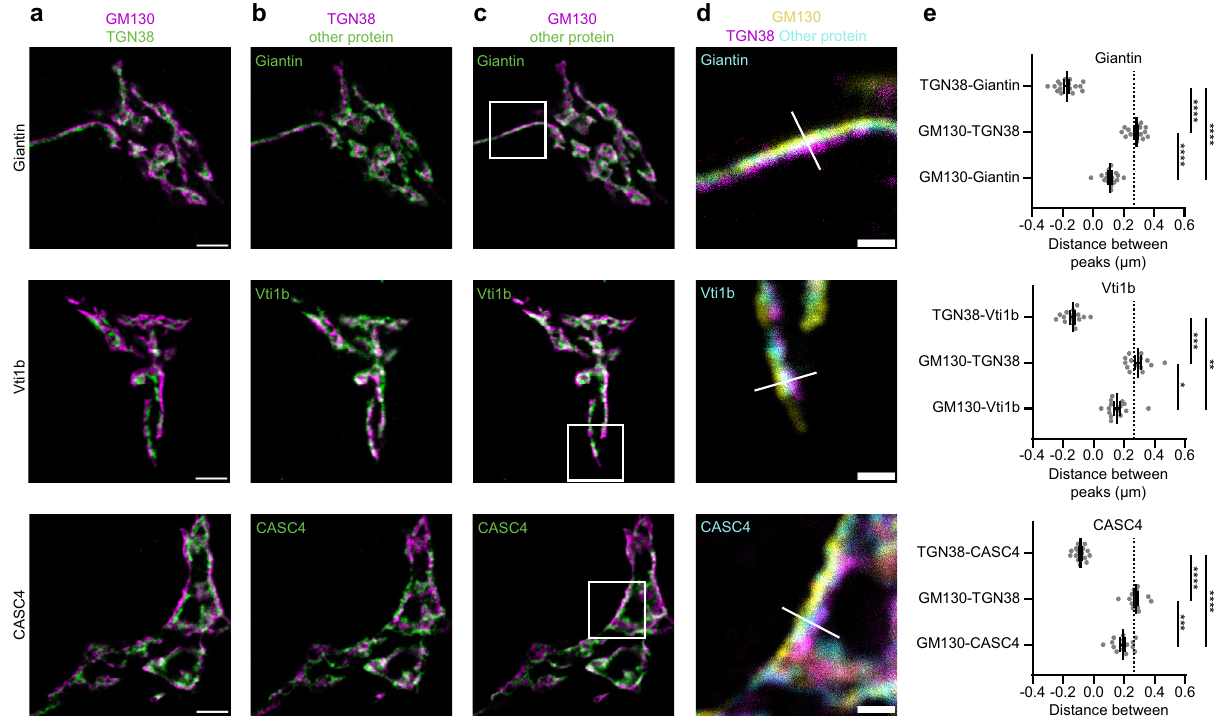
Figure 4. Several proteins localize upstream of TGN38. ( a–c ) Representative examples of neurons immunostained for cis -Golgi marker GM130, TGN38 and a protein of interest (Giantin, Vti1b and CASC4). Images showing immunostaining of cis -/medial Golgi marker and TGN ( a ), TGN and protein of interest ( b ), cis -/medial Golgi and protein of interest ( c ). ( d ) Zoom from the white square area marked in ( c ), showing all three stained proteins. White line is a representative example of a line drawn for intensity plotting. ( e ) Distance between intensity peaks of TGN38 and protein of interest, cis -Golgi and TGN; and cis -Golgi and protein of interest, measured by line scans. Giantin: (TGN38-Giantin: n = 16; GM130-TGN38: n = 16; GM130- Giantin: n = 16). One-way ANOVA with Tukey’s multiple comparisons test: TGN38-Giantin vs GM130- TGN38, TGN38-Giantin vs GM130-Giantin and TGN38-GM130 vs GM130-Giantin: **** p < 0.0001. Vti1b: (TGN38-Vti1b: n = 15; GM130-TGN38: n = 15; GM130-Vti1b: n = 15). Kruskall-Wallis test with Dunn’s multiple comparisons test: TGN38-Vti1b vs GM130-TGN38: **** p < 0.0001, TGN38-Vti1b vs GM130-Vti1b: ** p = 0.0025, TGN38-GM130 vs GM130-Vti1b: * p = 0.0201. CASC4: (TGN38-CASC4: n = 15; GM130-TGN38: n = 15; GM130-CASC4: n = 15). One-way ANOVA with Tukey’s multiple comparisons test: TGN38-CASC4 vs GM130-TGN38 and TGN38-CASC4 vs GM130-CASC4: **** p < 0.0001, TGN38-GM130 vs GM130-CASC4: *** p = 0.0001. Dotted lines represent average distance between TGN38 and GM130 in the entire dataset. Bars show mean ± SEM. Detailed statistics are shown in Supplementary Table 1. Scale bar is 3 µm ( a ) and 1 µm ( d